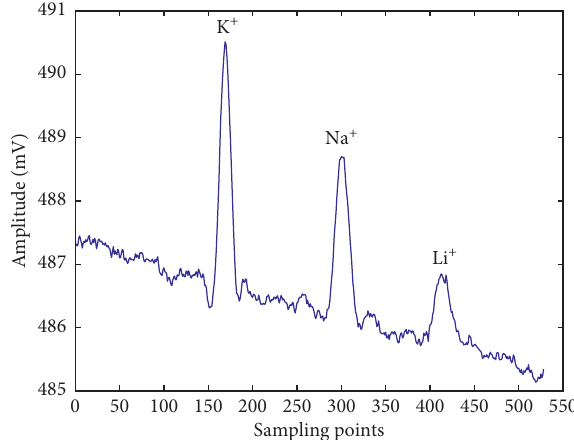
Figure 9: Detection signal with concentrations of 0.1mM.